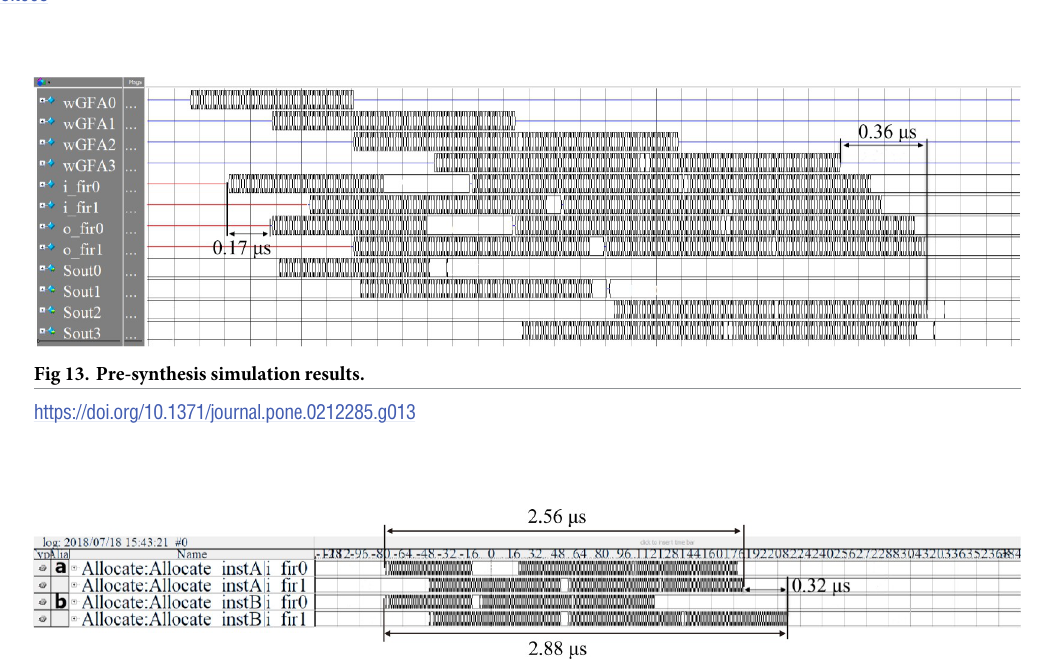
Fig 14. Results for four-pixel signal scheduling in two SPMs using Signaltap II. (a) SSPA algorithm and (b) FCFS or SPT